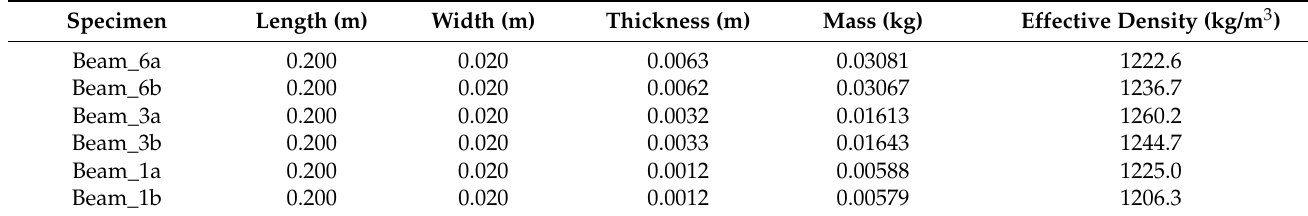
Table 2. Known geometrical and material data of